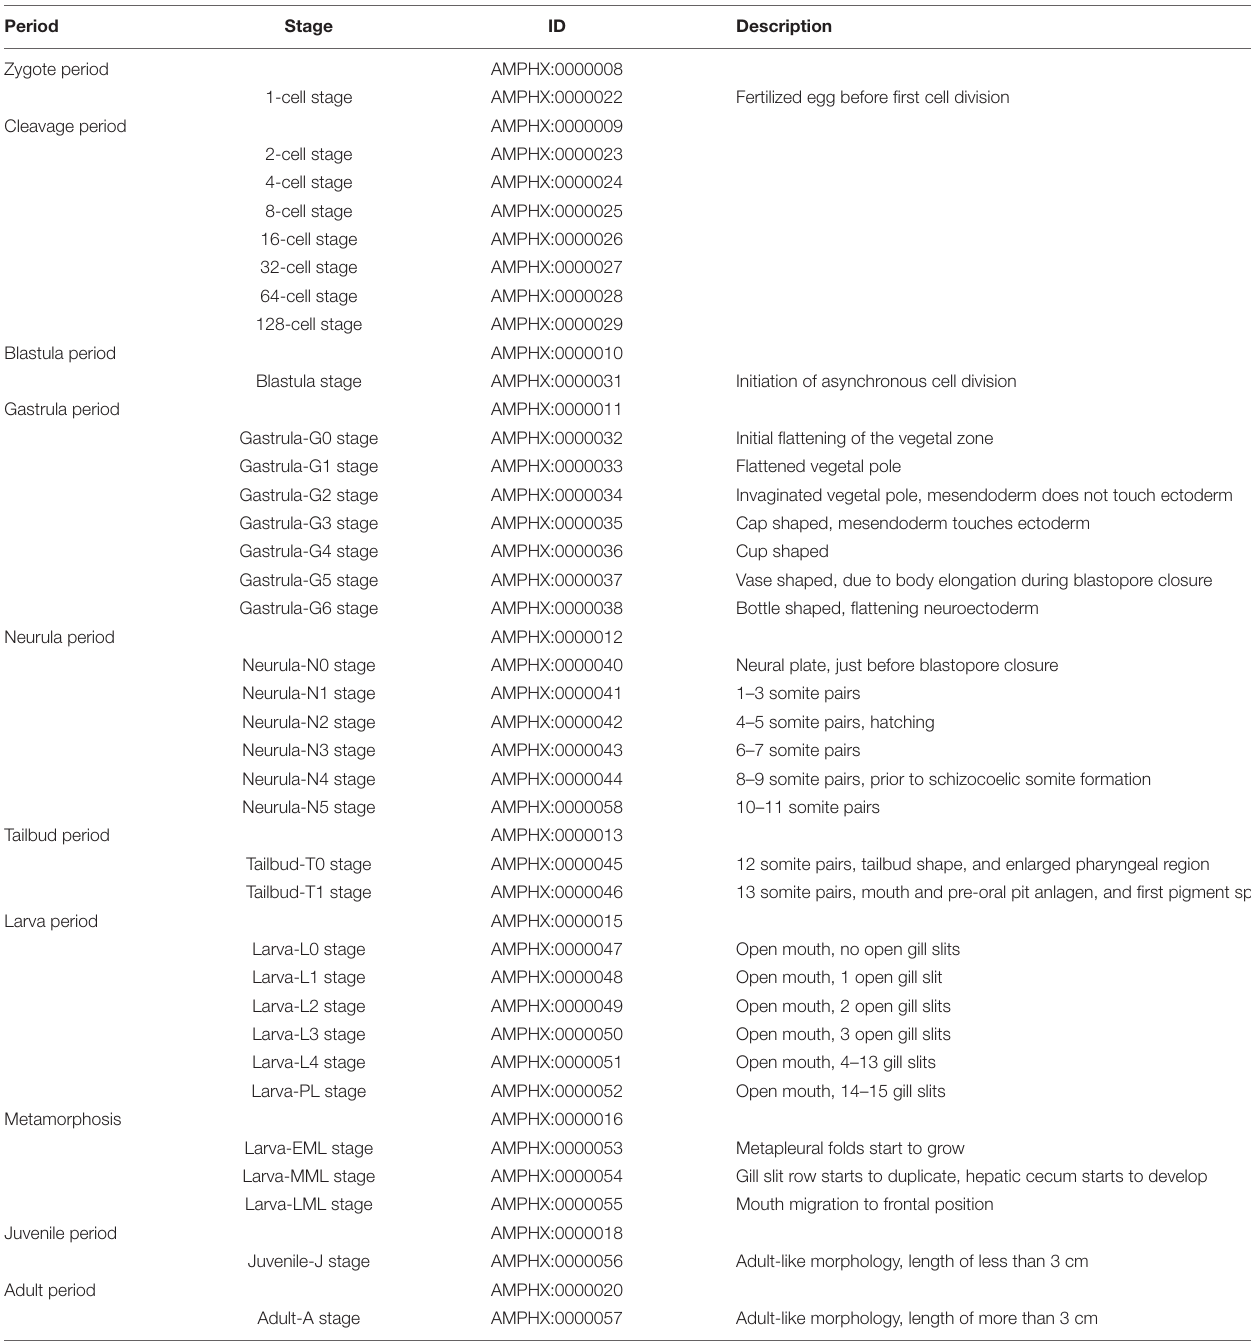
TABLE 1 | Amphioxus developmental periods and stages from the zygote to the adult.